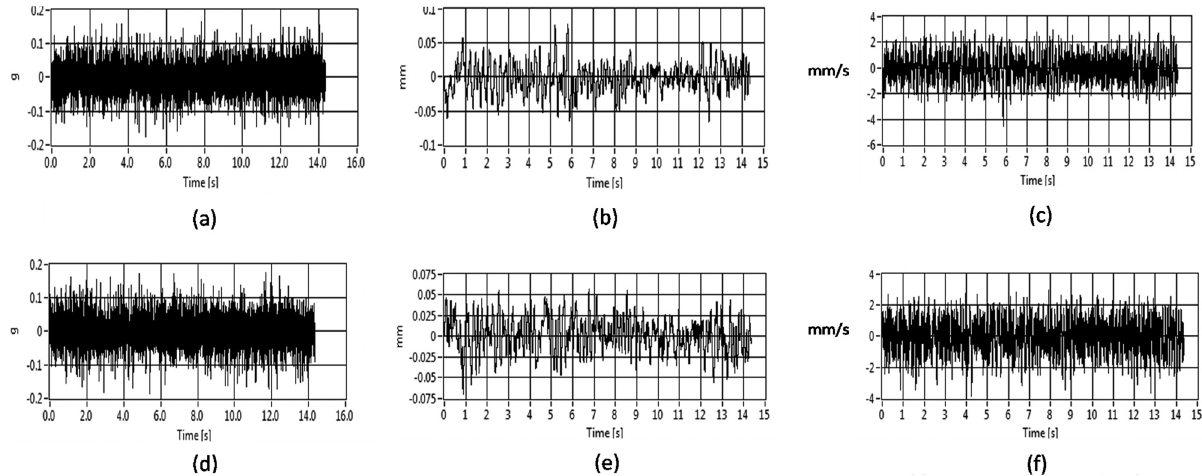
Figure 6: Variation in the amplitude of acceleration, displacement, and velocity with time measured at the surface of foundation embedment ( 1.0H ) . ( a ) Vertical acceleration, az; ( b ) vertical displacement, Az; ( c ) vertical velocity, Vz; ( d ) horizontal acceleration, a displacement, Ay; and ( f ) horizontal velocity,